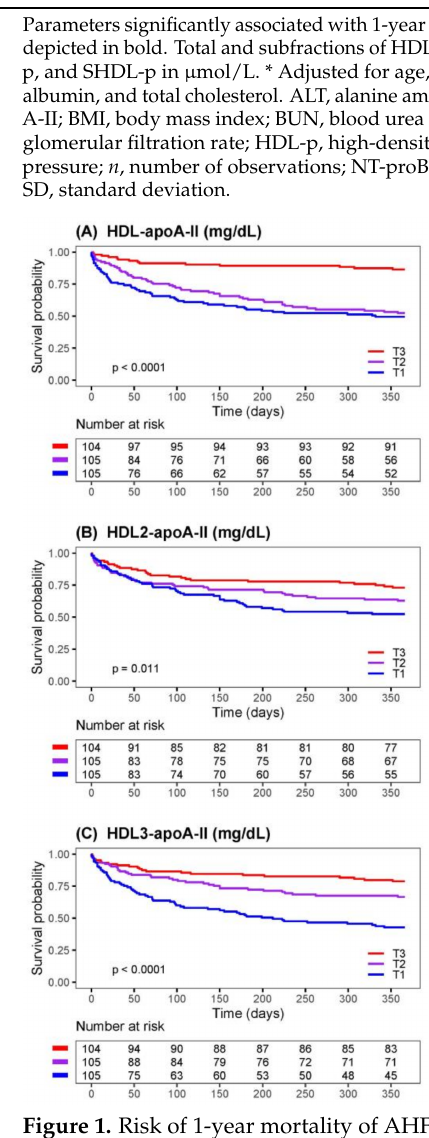
Figure 1. Risk of 1-year mortality of AHF patients stratified by tertiles of HDL parameters. Kaplan– Meier survival curves for 1-year mortality of AHF patients comparing tertiles of ( A ) HDL-apoA-II, ( B ) HDL2-apo-AII, and ( C ) HDL3-apoA-II. The number of patients at risk at each time point is presented below the graphs. The limits of the tertiles (T) in mg/dL: HDL-apoA-II (T1 = 7.84–21.67, T2 = 21.67–27.02, T3 = 27.02–49.23); HDL2-apoAII (T1 = 1.30–2.81, T2 = 2.81–3.55, T3 = 3.55–7.70); HDL3-apoA-II (T1 = 1.15–4.17, T2 = 4.17–5.55, T3 =